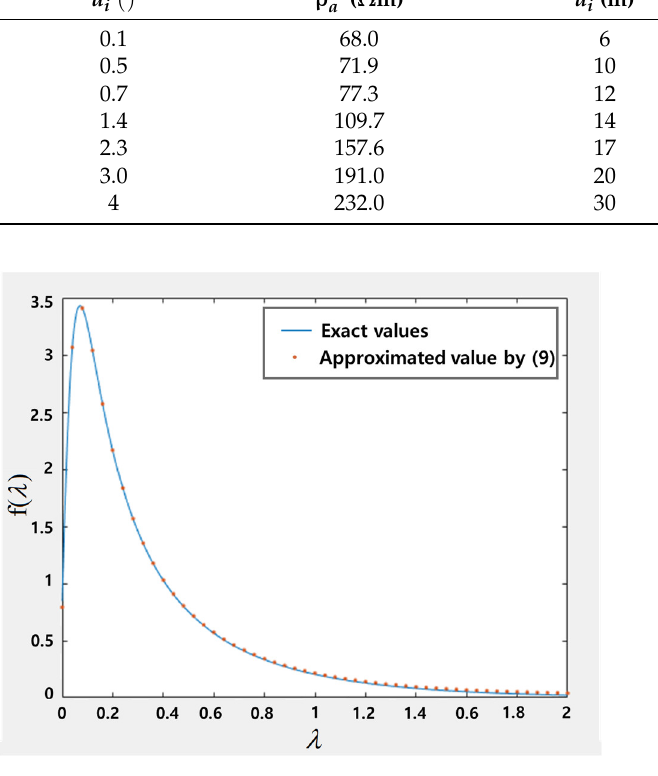
Figure 8. The estimated kernel functions using the data in Table 5.